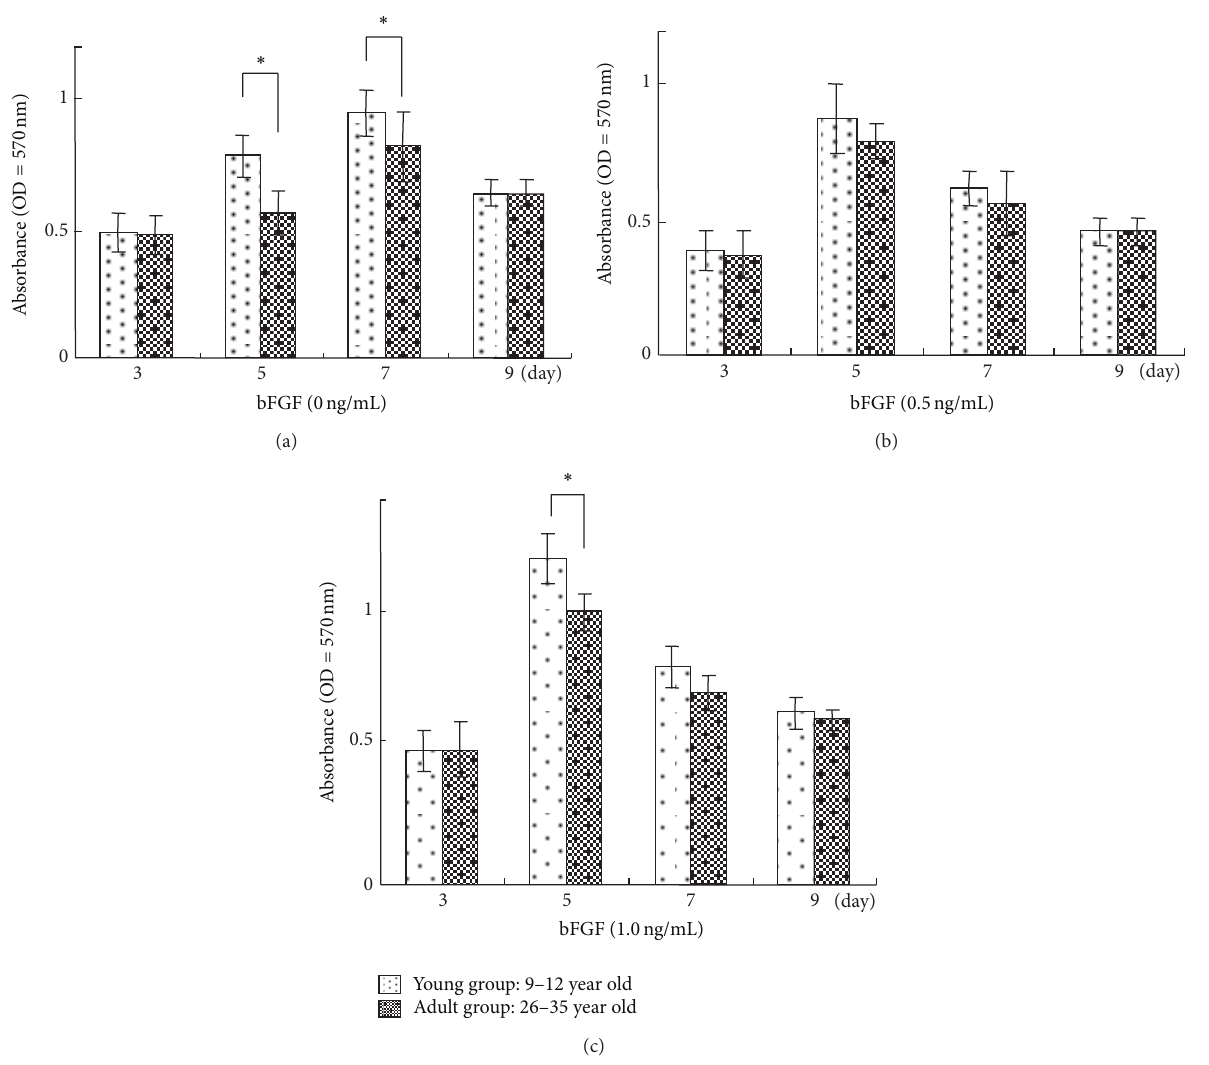
Figure 1: Proliferation of cultured human GFs induced by addition of bFGF. GFs were seeded at a density of 1.0 × 10 3 cells/well. Cell proliferation of cultured GFs with 0 (a), 0.5 (b), and 1.0 (c)ng/mL bFGF was evaluated by measuring BrdU incorporated into the DNA of proliferating cells 3, 5, 7, and 9 days after seeding. Error bars indicate a standard deviation. 𝑁 = 8 , ∗ 𝑃 < 0.05 , ∗∗ 𝑃 < 0.01